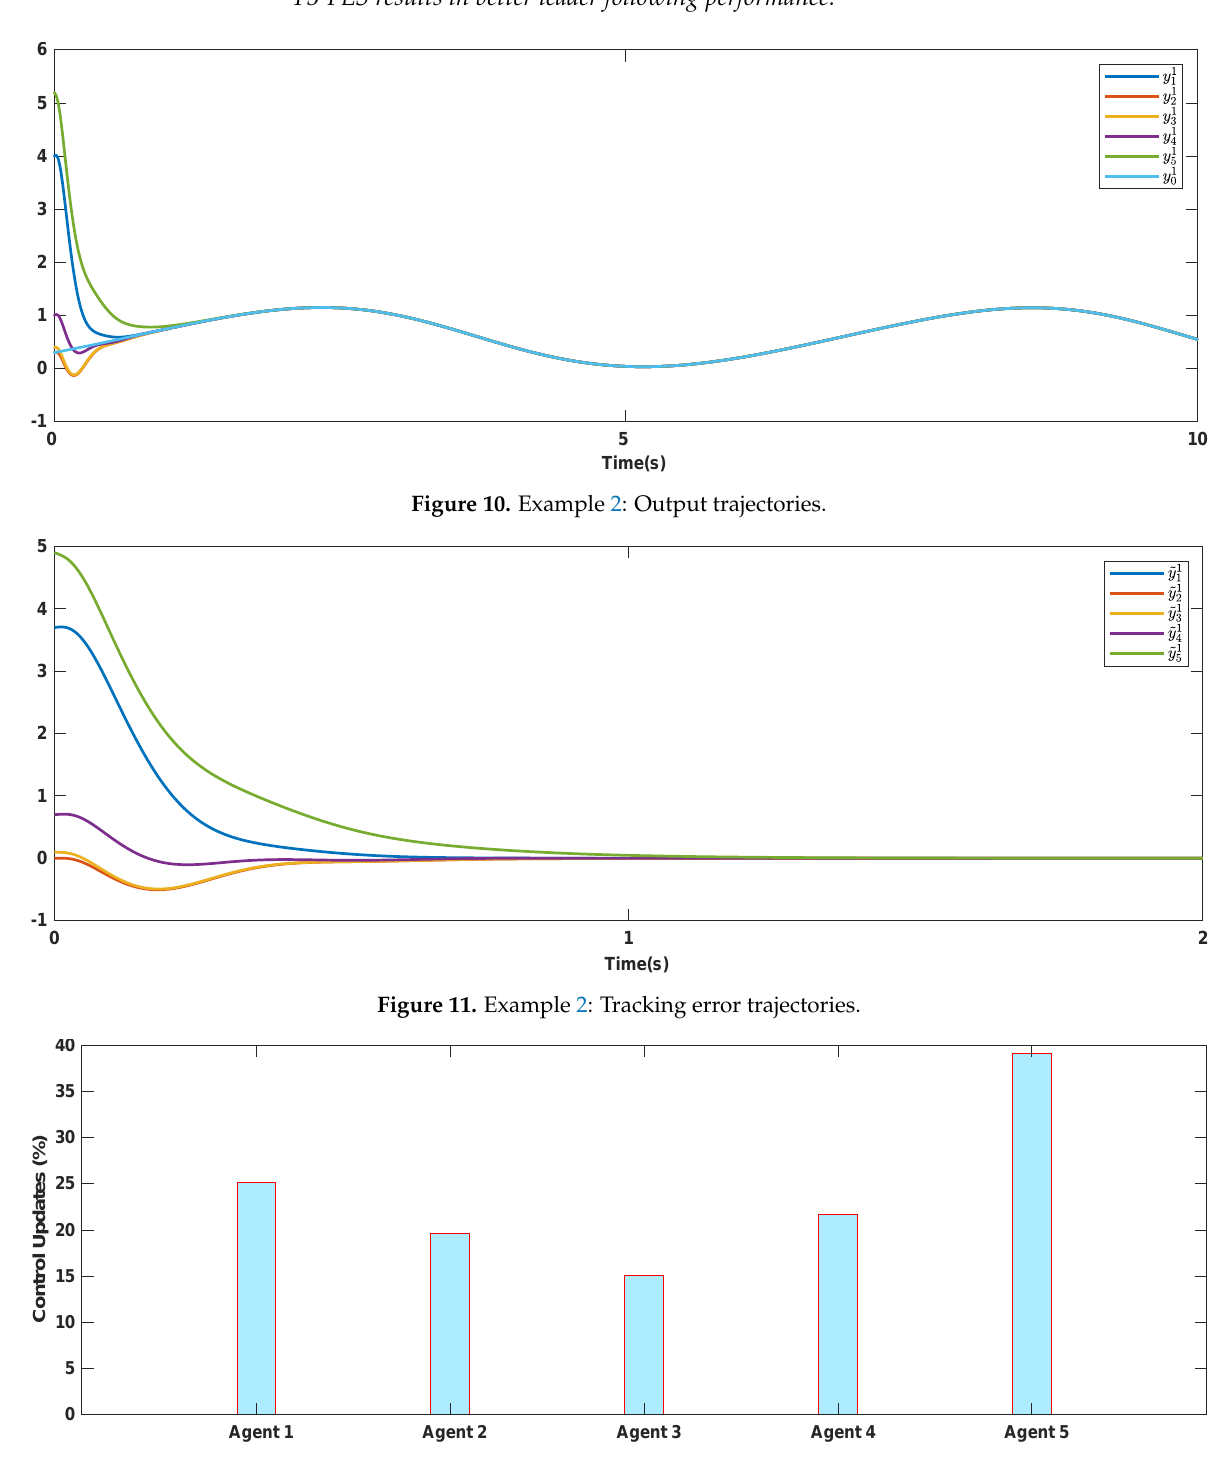
Figure 12. Example 2: Percent of control system